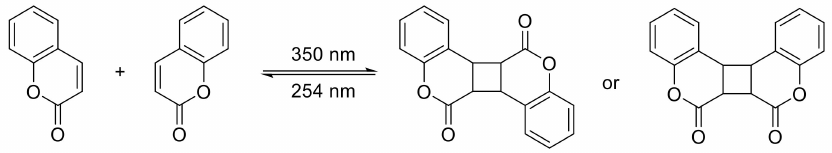
Figure 32. Reversible photodimerization of a coumarin ring.